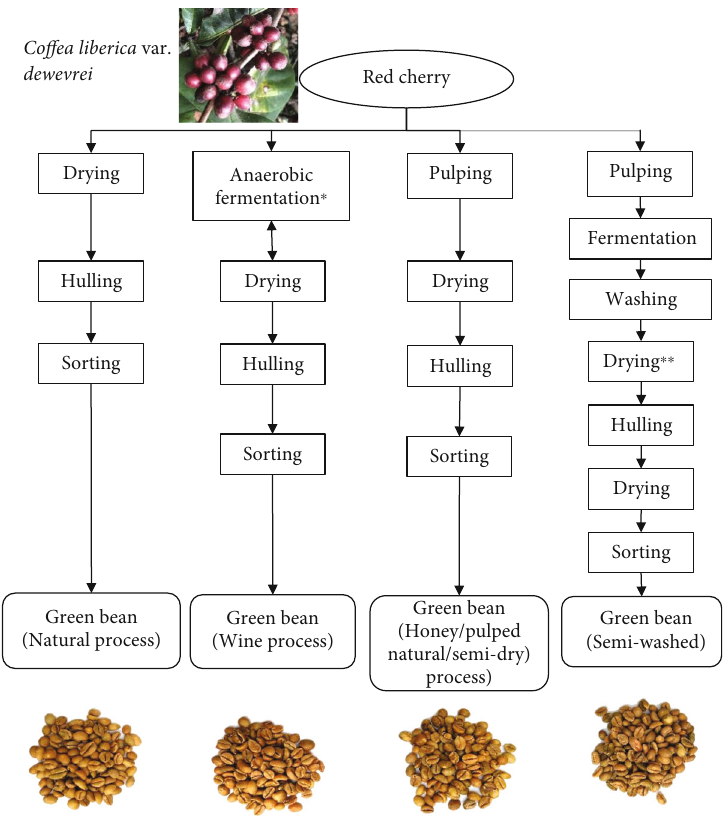
Figure 1: Main steps for di ff erent postharvest processing of Excelsa co ff ee (Co ff ea liberica var. dewevrei). ∗ The anaerobic condition is intercepted for the drying process repeatedly until the farmers get the desired moisture content. ∗∗ Initial drying reaches moisture content approximately